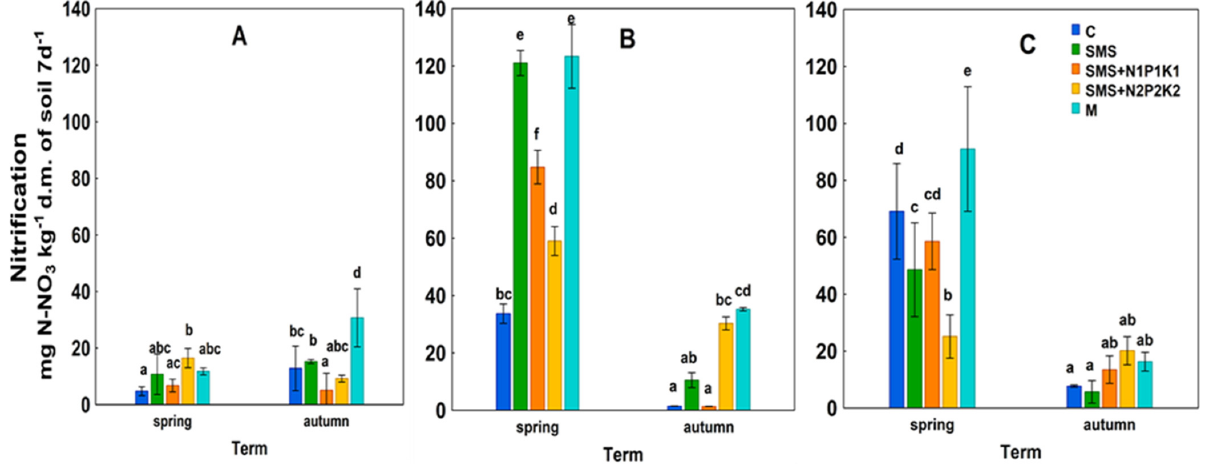
Figure 8. Nitrification in the control soil and soil under different treatment strategies. Legend: C—control; SMS—soil + spent mushroom substrate; SMS + N1P1K1—soil + spent mushroom substrate + mineral fertilization N1P1K1; SMS + N2P2K2—soil + spent mushroom substrate + mineral fertilization N2P2K2; M—soil + manure; ( A )—1st year; ( B )—2nd year; ( C )—3rd year. The vertical lines indicate the standard deviation. Different letters above the columns indicate significant differences, each year was analyzed independently of each other.